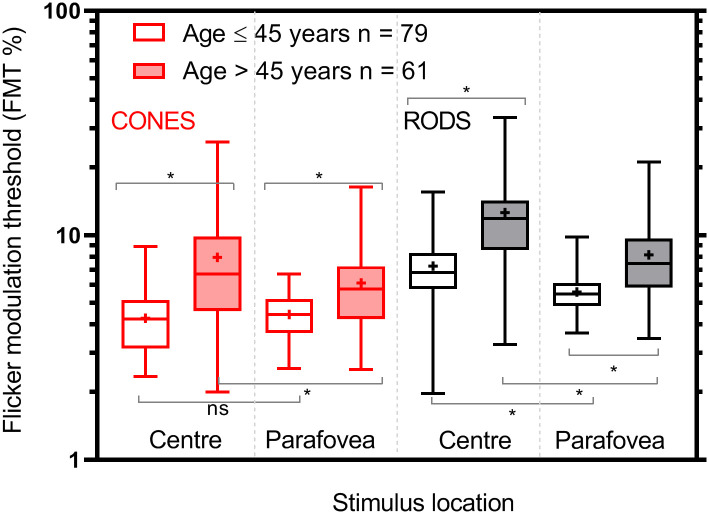
Box plots of cone enhanced and rod enhanced FMTs at the centre and parafoveal locations for both age groups.Box plot showing the median, first quartile, third quartile, minimum and maximum FMT for each cohort. The solid boxes represent younger age cohort (< 50 years), and unfilled boxes represent elderly cohort (≥ 50 years). The plus symbols refer to the mean of each distribution. The asterisk indicates the comparisons that were significantly different from each other.